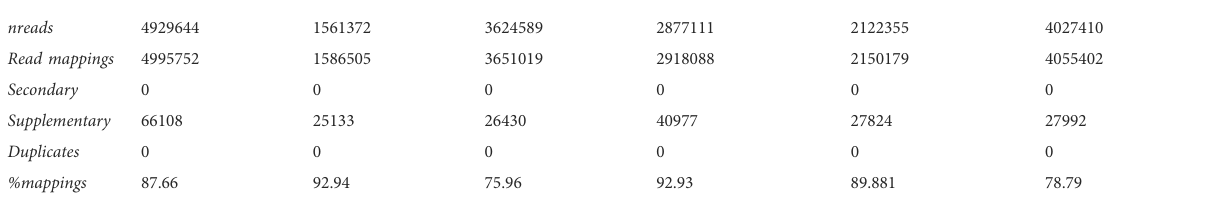
TABLE 1 Mapping summary of sequences aligned with